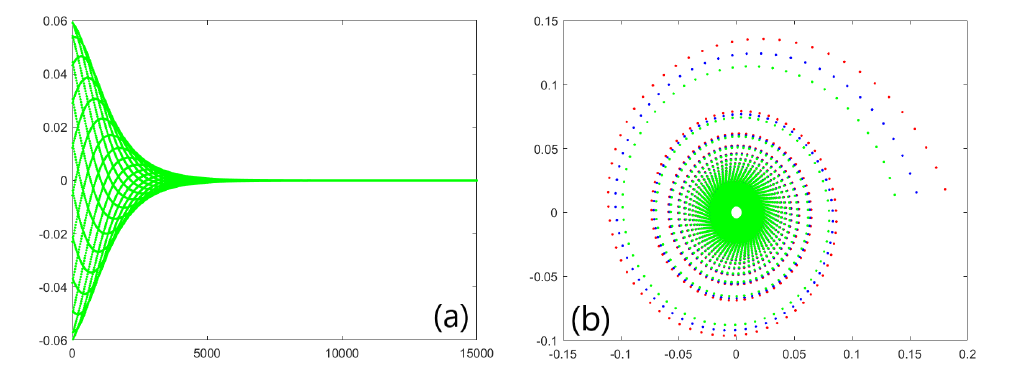
Figure 15. Numerical simulations for the map (9) when β 1 ( α ) = α 3 β 2 ( α ) = − α 1 − 3 α 2 and ( α 1 , α 2 ) = ( 0.1, − 0.1 ) : ( a ) four orbits corresponding to ( ρ 1 , ϕ 1 ) = ( 0.06,0 ) (the orbit in red), ( ρ 1 , ϕ 1 ) = ( 0.187,0 ) (the orbit in blue), ( ρ 1 , ϕ 1 ) = ( 0.0716,0 ) (the orbit in magenta), ( ρ ) = ( 0.06 ) (the orbit in green); ( b ) the sequence ρ n in the plane ( nO ρ n ) corresponding to the 1 , ϕ 1 green orbit, when N = 6000 from ( a ).